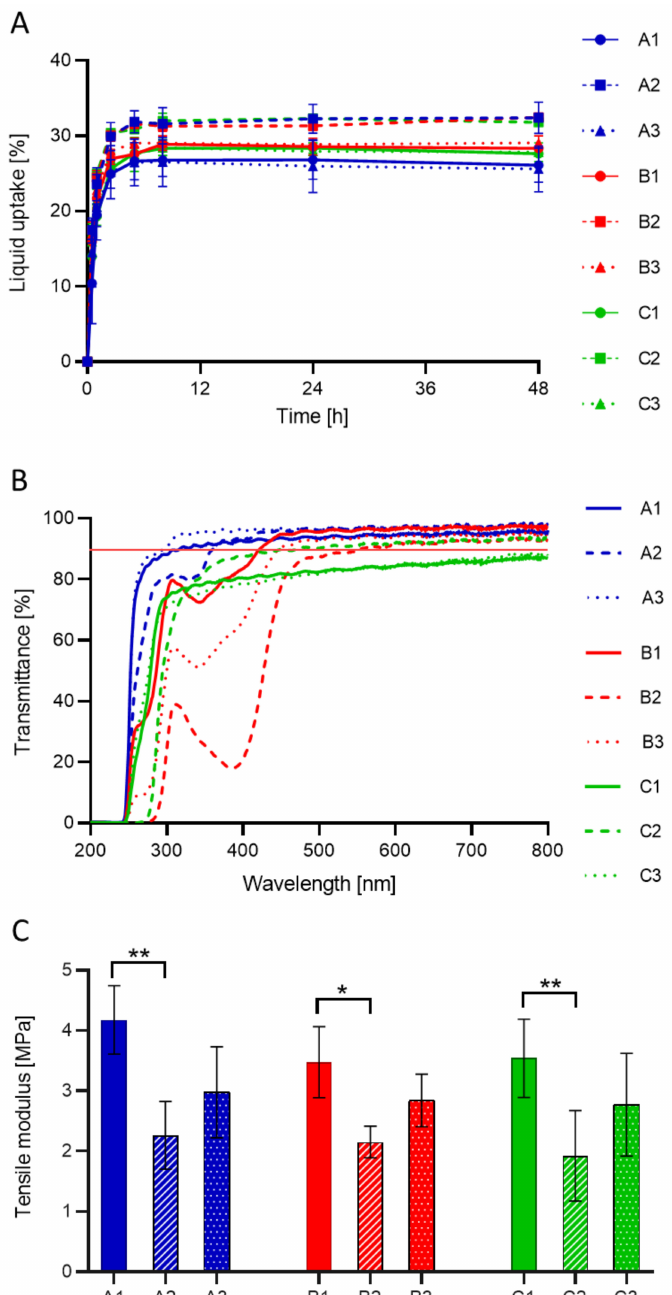
Figure 2. Physical and mechanical characterization of the designed hydrogels prior to drug-loading: liquid uptake ( A ), light transmittance ( B ) and mechanical properties ( C ). One-way ANOVA, * p < 0.05; ** p < 0.01. Hydrogel codes as in Table